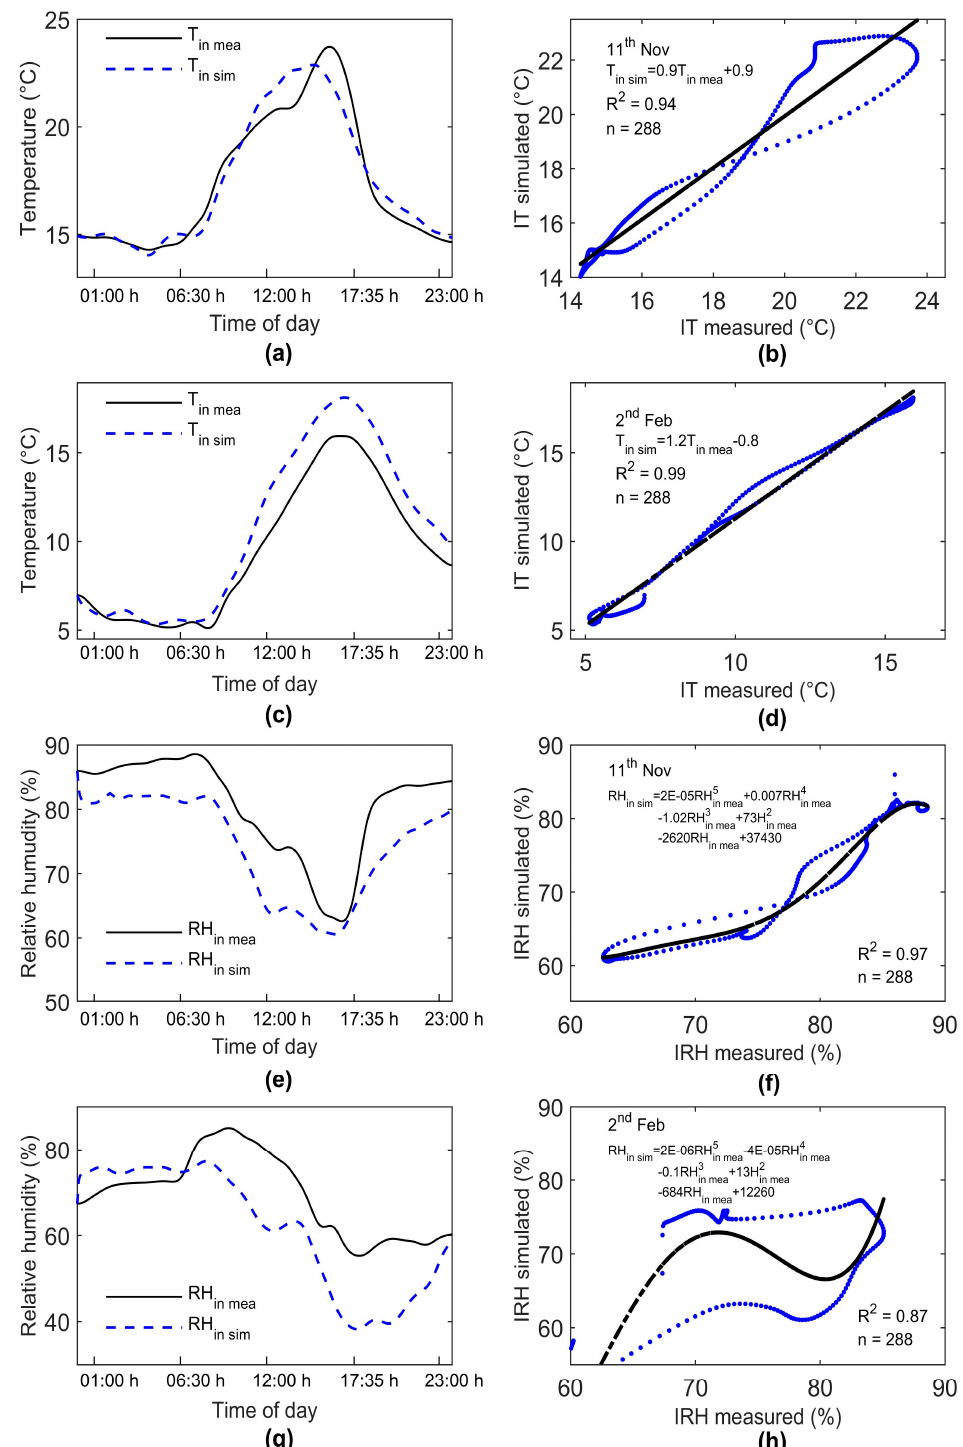
Figure 3. Results of the simulation of temperature and humidity during two days in different seasons (autumn: 11 November 2015 and winter: 2 February 2016). ( a ) The temperature in autumn. ( b ) Regression analysis of temperature in autumn, R 2 = 0.94. ( c ) The temperature in winter. ( d ) Regression analysis of temperature in winter R 2 = 0.99. ( e ) Humidity in autumn. ( f ) Regression analysis of humidity in autumn, R 2 = 0.97. ( g ) Humidity in winter. ( h ) Regression analysis of humidity in winter, R 2 = 0.87.